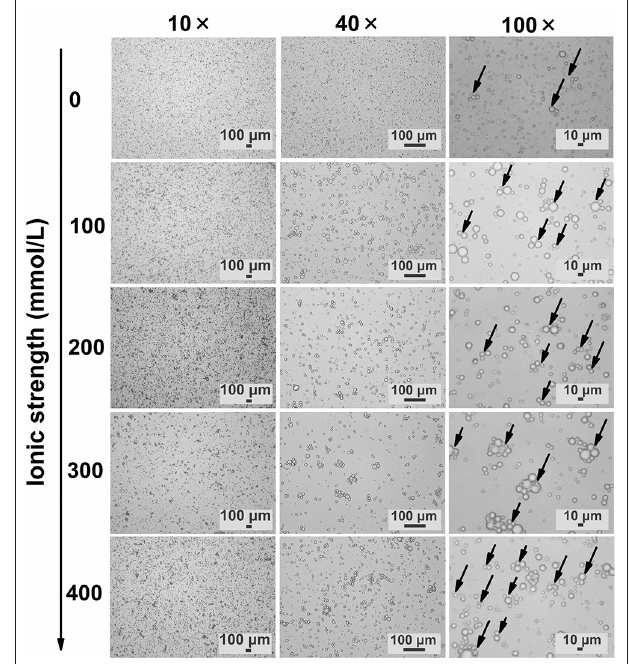
FIGURE 3 | Microscopic observation of Pickering emulsions stabilized by tea water-insoluble protein nanoparticles under different ionic strengths (left: ionic strength; upper: magnification times. Arrows indicate the